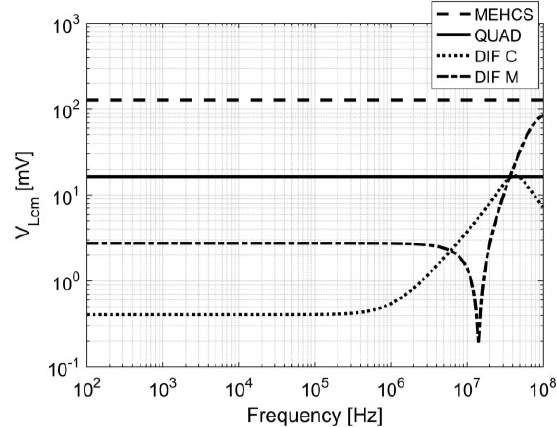
Fig.17: Simulated AC common mode load voltage ( V Lcm ) of the mirrored group and proposed group. MEHCS-DIF and MEHCS have the same curve.